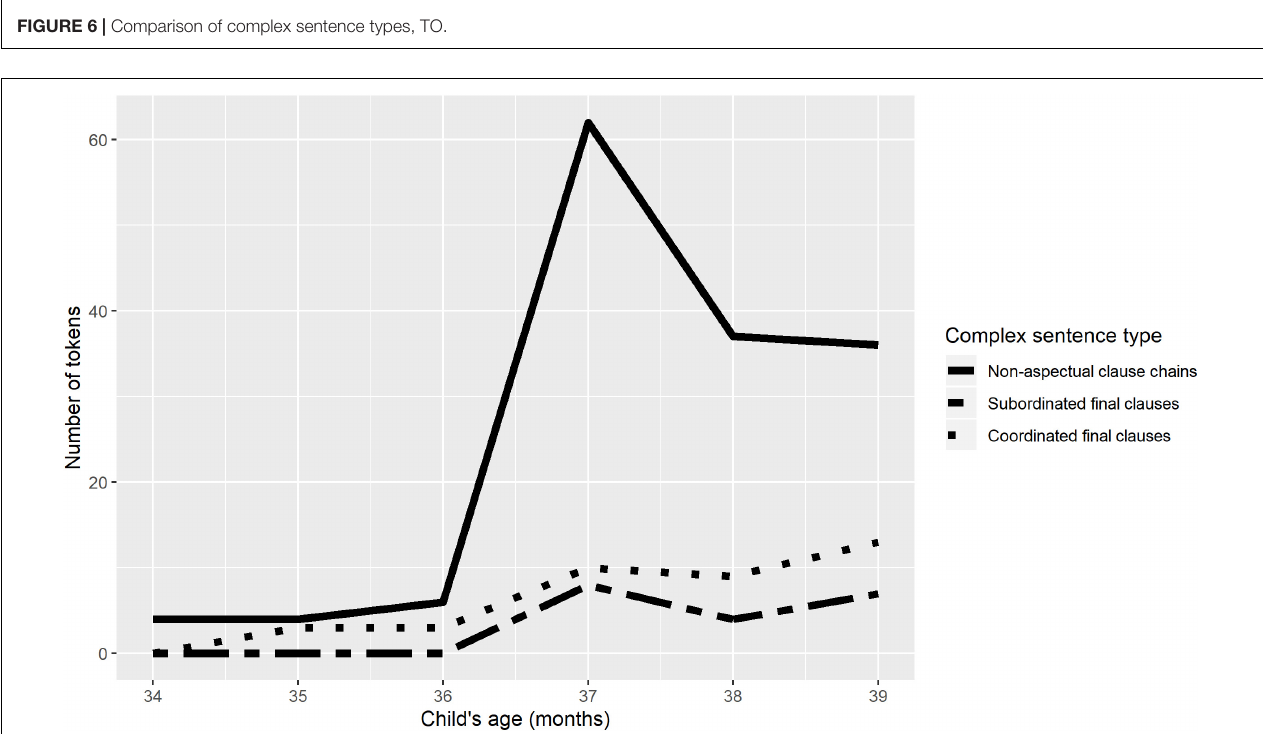
FIGURE 7 | Comparison of complex sentence types,